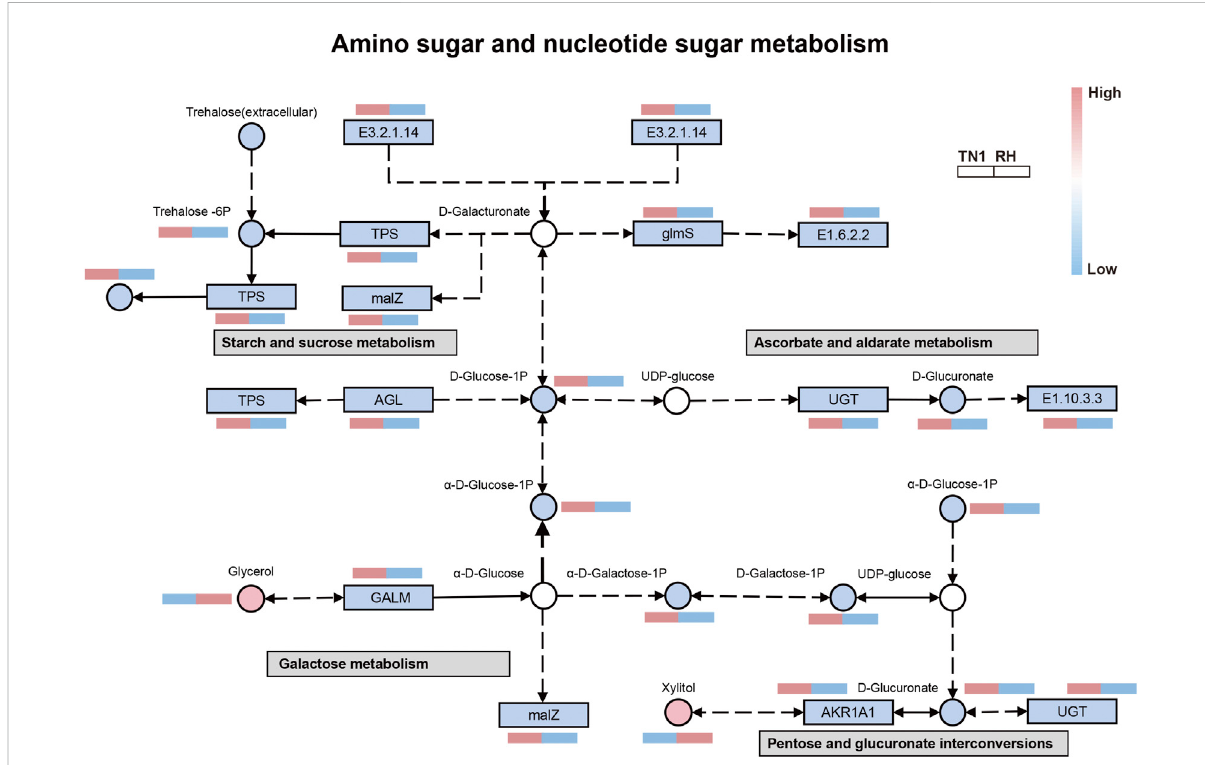
FIGURE 5 Integrated analysis of regulated pathways identi fi ed by transcriptomic and metabolomic analyses. Rectangle and circles represent genes and metabolites, respectively. For genes and metabolites, blank, red and blue indicate no difference in expression, upregulated factors and downregulated factors,